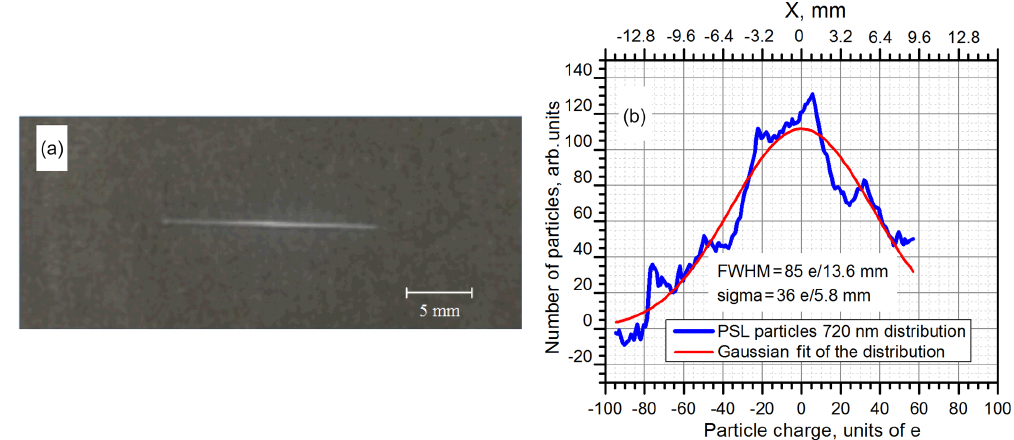
Figure 6. The distribution of 720nm particles moved through the electrical field formed with a 2000V potential difference between the electrodes in the extraction region collected on the glass plate. (a) Photo of the trace from particles on the glass plate. (b) The extracted particle charge distribution from the density profile in (a) by ImageJ software and the Gaussian approximation of the profile.